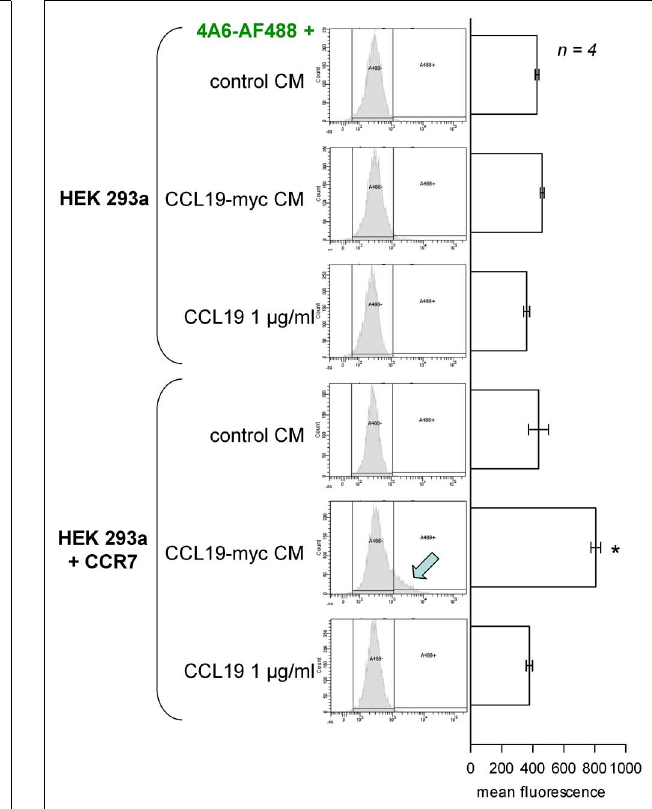
FIGURE 3 | Cytofluorometry of HEK 293a cells that optionally expressed CCR7, sequentially detached and further stimulated with the undiluted CM of other cells producing CCL19-myc, authentic CCL19, or CM of untransfected cells, as indicated (30 min incubation at 37 ◦ C). Left: distributions based on the counting of 10,000 cells. A threshold of autofluorescence was defined using control cells with no fluorophore. It was surpassed only under one set of experimental conditions (arrow). Right: mean fluorescence of cells in replicated experiment. ANOVA indicated that the values were heterogeneous ( p < 10 − 4 ). * p < 0.01 vs. top-most value (control CM, untransfected recipient cells) by Dunnett’s